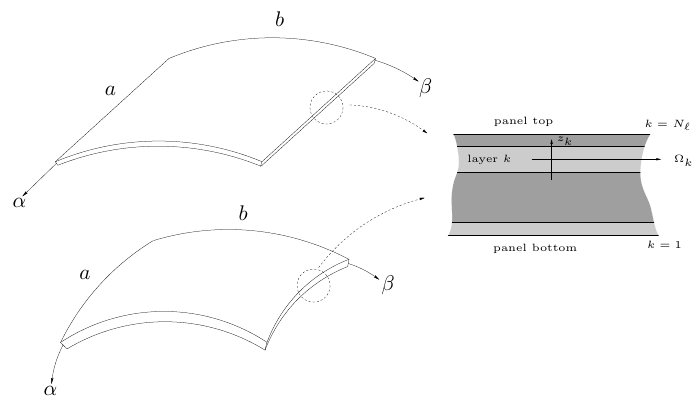
Figure 1: Geometry of the multilayered cylindrical and spherical panels considered in this work and details of the lamination